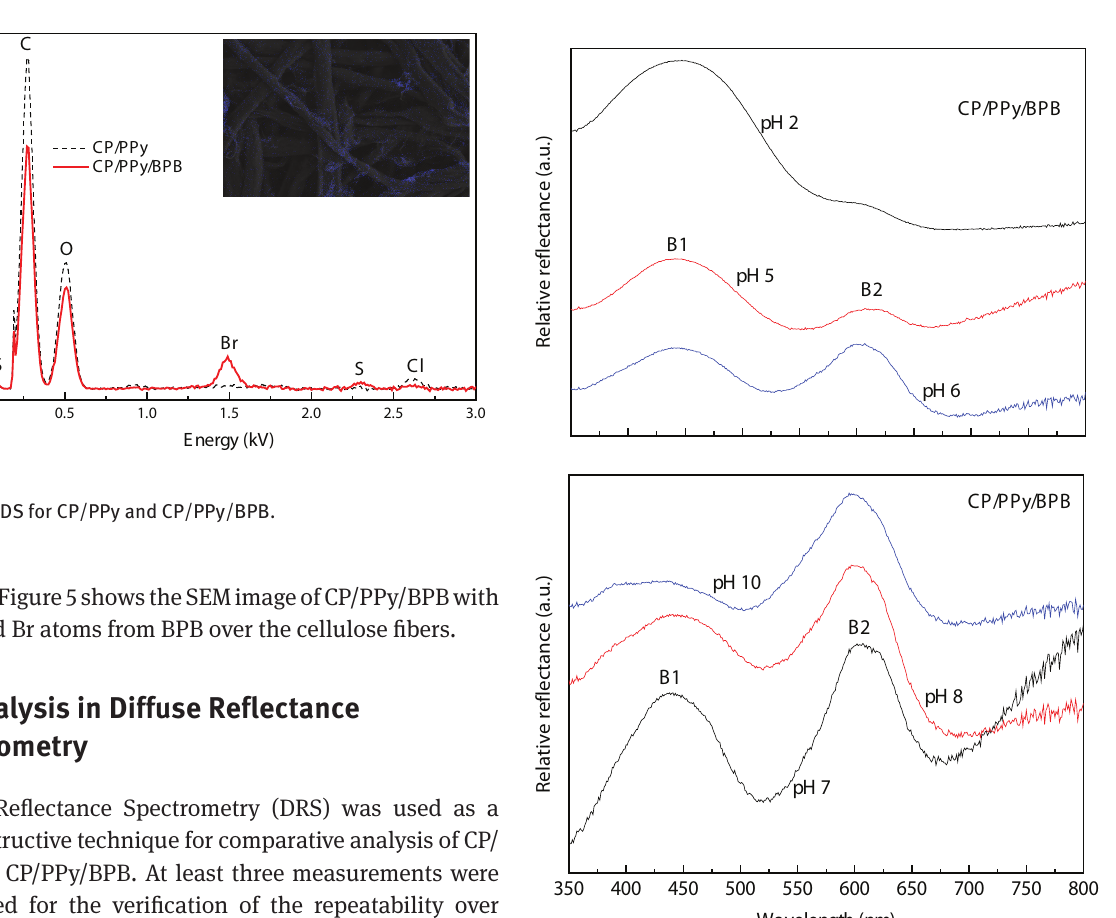
insert of Figure 5 shows the SEM image of CP/PPy/BPB with adsorbed Br atoms from BPB over the cellulose fibers.